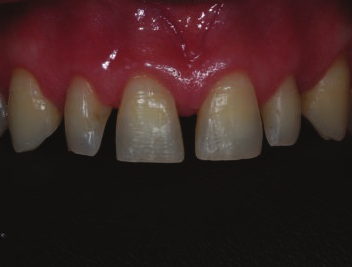
Figure 8: Measurements of the distance between the guide edge and the cervical bone for the osteotomy.